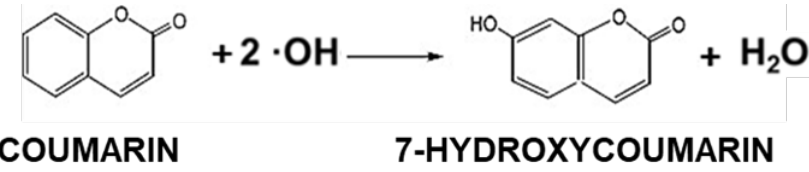
Figure 8. Coumarin and hydroxyl radical reaction to produce 7-hydroxycoumarin.